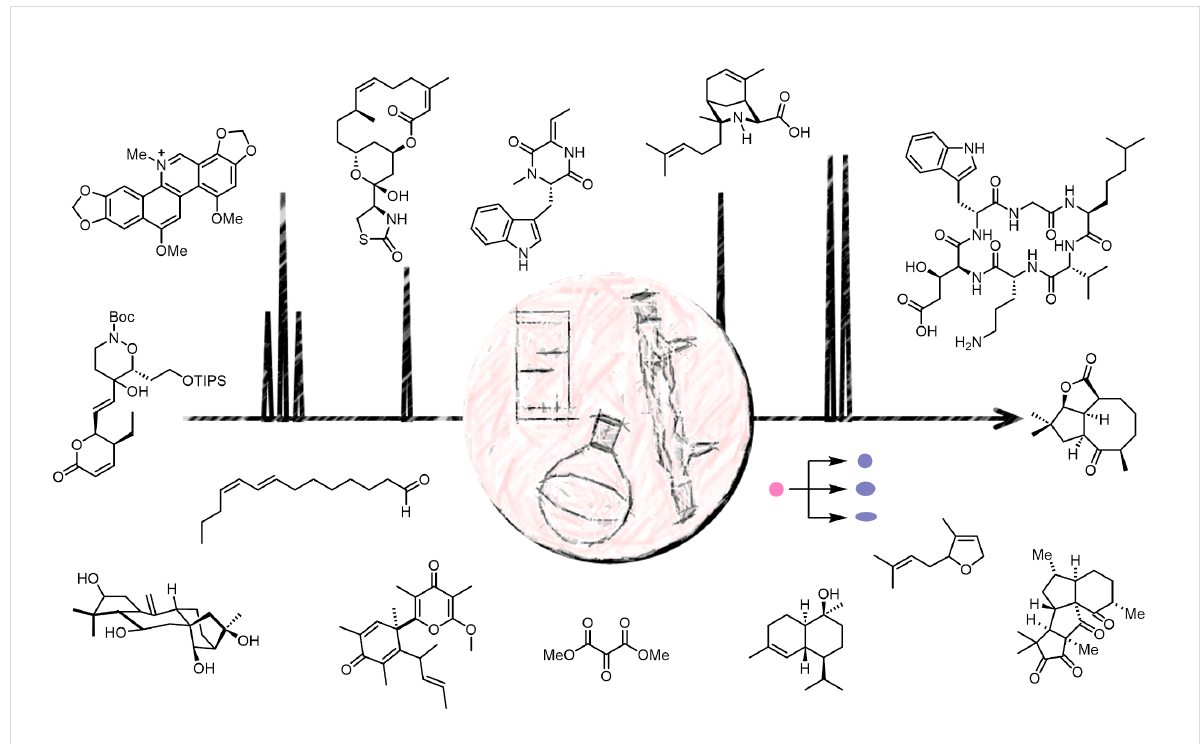
Figure 1: A summary of compounds targeted in this thematic